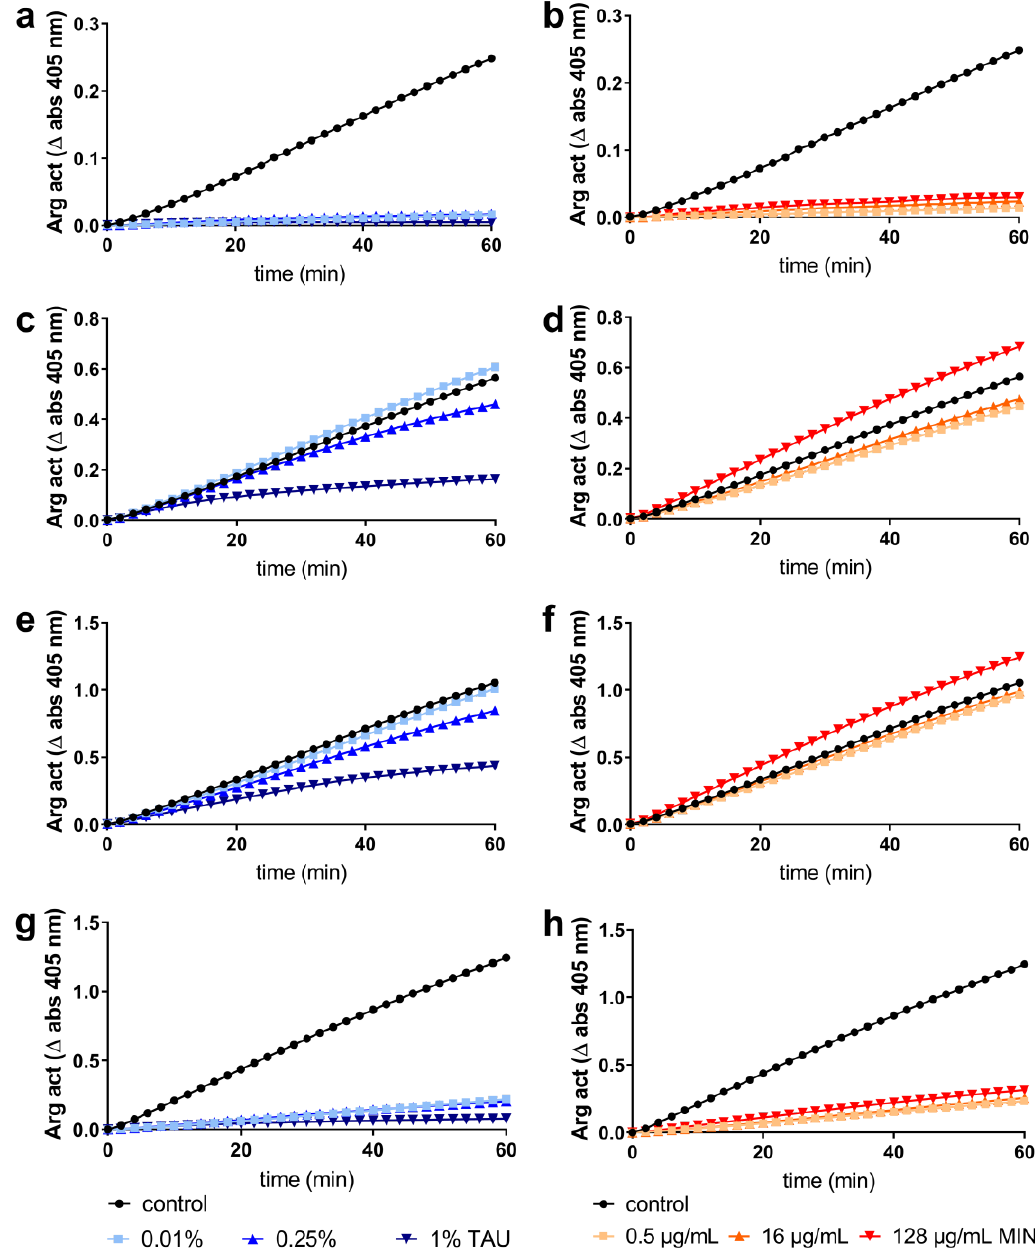
Figure 4. Arginine specific amidolytic activity (Arg act) measured by ∆ abs 405 nm after addition of taurolidine (TAU; a , c , e , g ) and minocycline (MINO; b , d , f , h ) in di ff erent concentrations to 10 nM RgpB ( a , b ), Porphyromonas gingivalis ATCC 33277 ( c , d ), P. gingivalis J374-1 ( e , f ) and P. gingivalis HG66 ( g , h